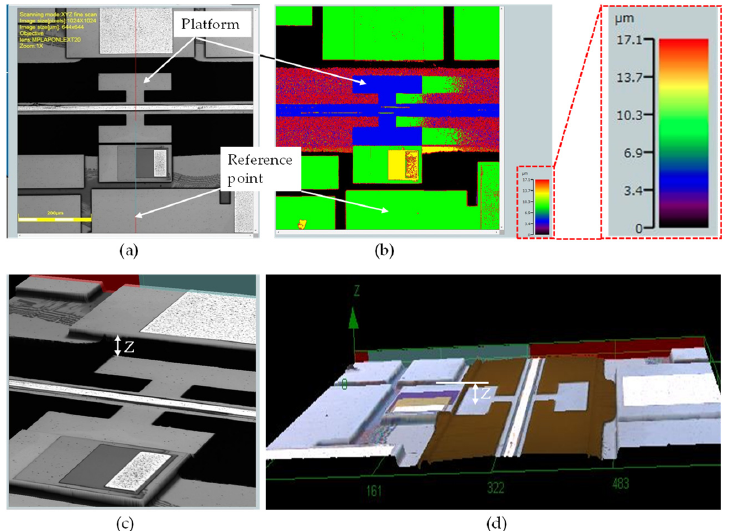
Figure 5. Initial deformation of the platform below the reference point due to residual stress: ( a ) the platform and reference measurement point, ( b ) color image highlighting the different levels of the platform and reference point, and ( c , d ) 3D pictures showing the z-axis height between the platform and the reference level.